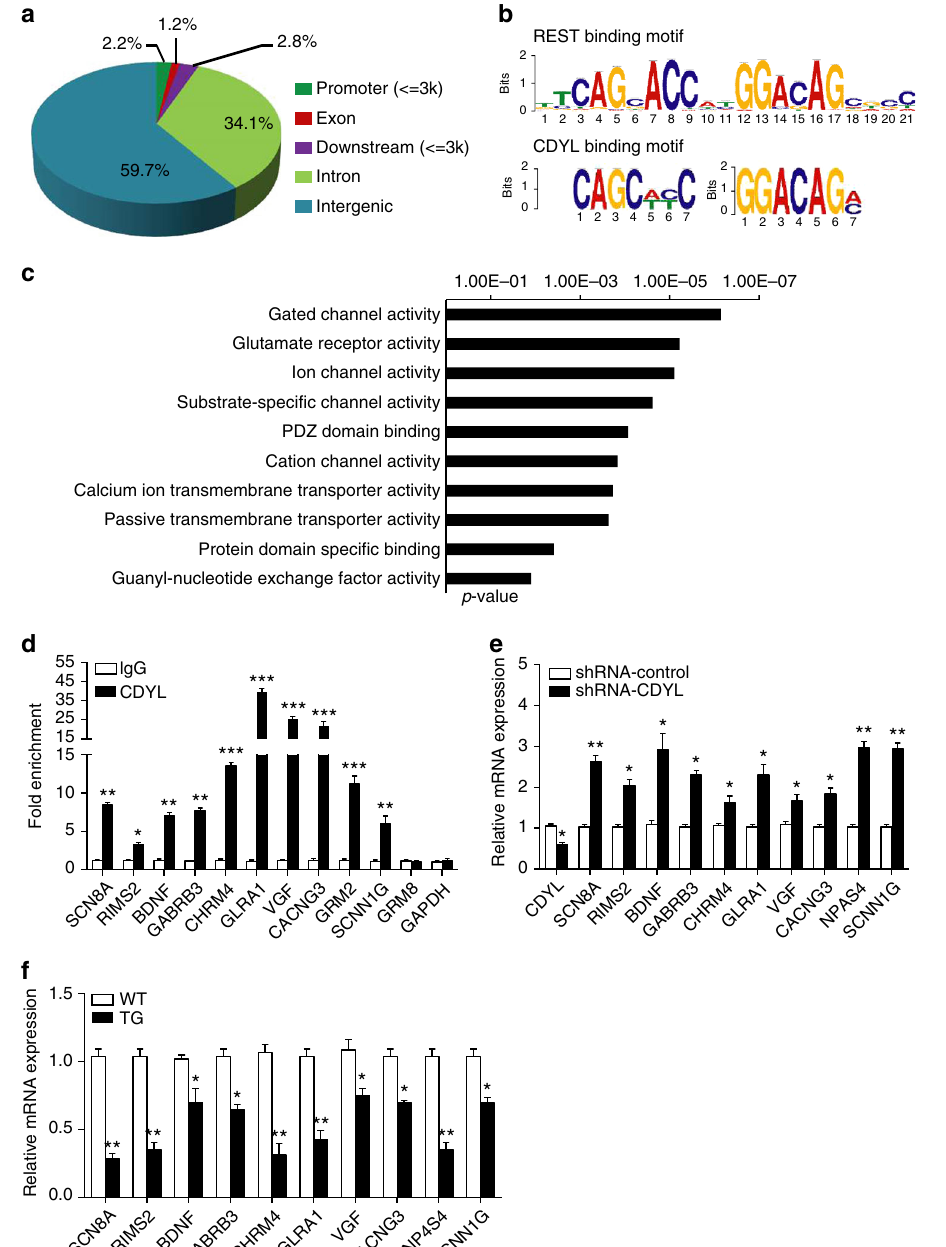
Fig. 4 Genome-wide identi fi cation of CDYL target genes in mouse hippocampus. a Genomic distribution of CDYL binding regions determined by ChIP-seq analysis. b Consensus CDYL binding motif is nearly identical to the REST binding motif. Motif screening was performed using MEME suite. c Classi fi cation of the genes identi fi ed in ChIP-seq experiments with GO analysis. d Veri fi cation of the ChIP-seq results in mice hippocampus tissues by ChIP-qPCR. Results are represented as fold change over GAPDH negative control. n = 3, * p < 0.05, ** p < 0.01, *** p < 0.001, paired two-tailed Student ’ s t -test. e , f Quantitative real-time RT-PCR analysis to measure the mRNA levels of indicated genes. Hippocampus tissues were obtained from mice infected with lentiviruses containing CDYL shRNA or nonsilencing shRNA for 14 days ( e ), or from adult WT or CDYL-TG littermates ( f ). Total RNAs were prepared and mRNA levels of the indicated genes were examined by real-time RT-PCR. The levels of mRNA were normalized against that of GAPDH. * p < 0.05, ** p < 0.01, paired two- tailed Student ’ s t -test. Data were represented as mean ± cells. For this purpose, whole-cell current-clamp recordings were Neither the morphology (Supplementary Fig. 2g, h) nor resting used in rat brain slices infected with control- or CDYL-shRNA membrane potentials (RMPs) of neurons were changed with on14 – 21 DPI. The experiments were performed in the presence CDYL-shRNA infection (CDYL-shRNA infected neurons RMP, − 77.91 ± 0.58, n = 34; nonsilencing-shRNA infected neurons of inhibitors of glutamate and GABA receptors, unless otherwise stated. Hippocampal DG granule cells were identi fi ed by large RMP, − 77.23 ± 0.89, n = 20; non-infected neurons RMP, − 78.08 ± 0.48, n = 33) (Supplementary Table 1). Interestingly, input resistances (RN) of 166.38 ± 6.11( n = 33) and complex dendritic trees as revealed by post-hoc morphological analysis. when membrane potentials were held at − 80 mV with current